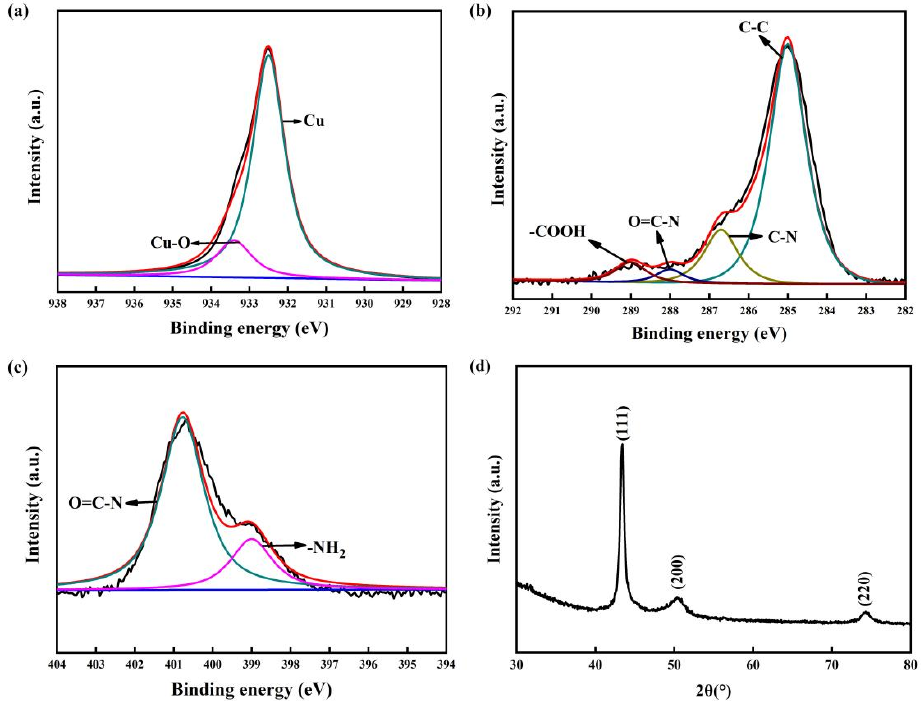
Figure 4. XPS and XRD patterns of Cu/COOH-APTMS/SiO 2 /Si: ( a ) XPS analysis of Cu; ( b ) XPS analysis of C; ( c ) XPS analysis of N; ( d ) XRD pattern.